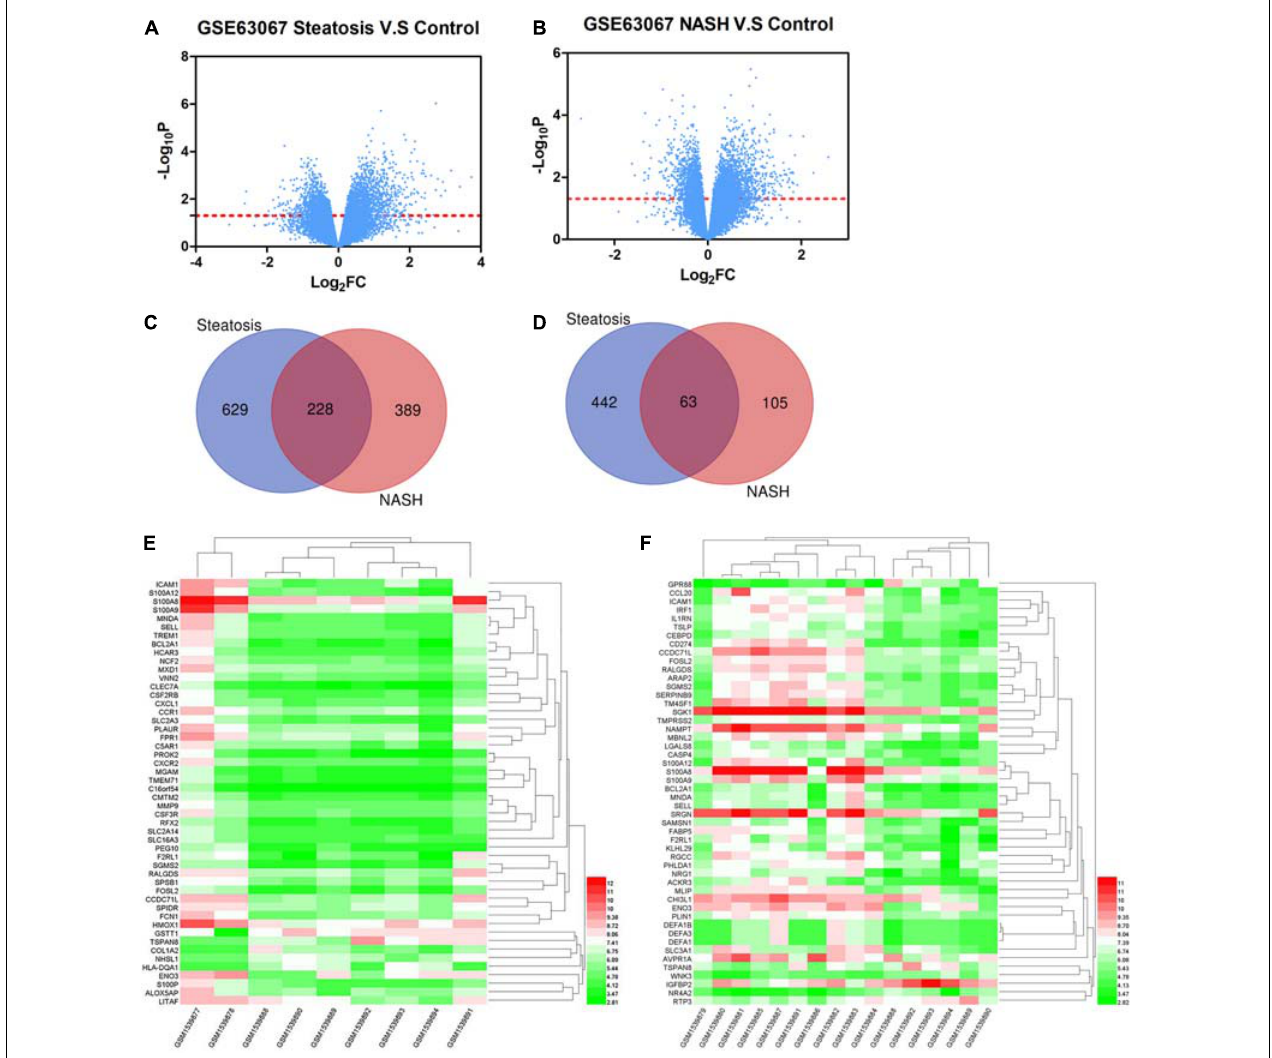
FIGURE 1 | (A) The expression of all genes in steatosis vs. Control. (B) The expression of all genes in NASH vs. Control. (C) Venn diagram of upregulated genes in steatosis and NASH. (D) Venn diagram of downregulated genes in steatosis and NASH. (E) Top 50 differential genes in steatosis vs. Control. (F) Top 50 differential genes in NASH vs. Control.